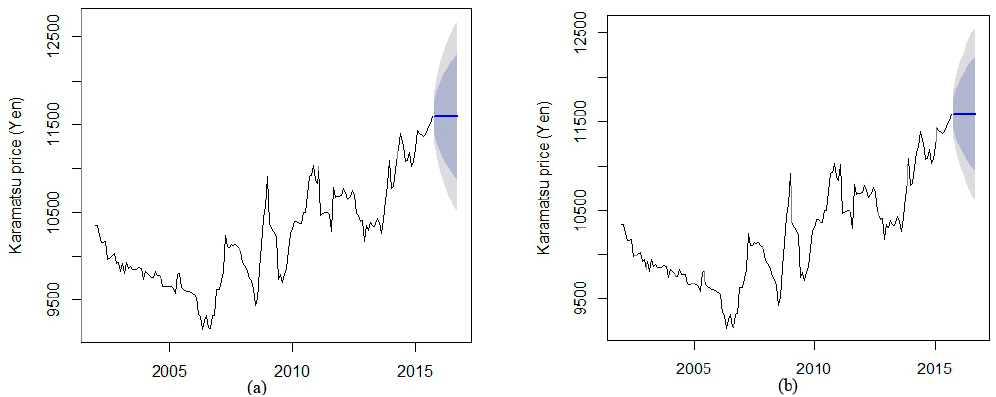
Figure 7. Forecasts of the karamatsu log prices: ( a ) Point forecasts and forecast intervals at 80% and 95% levels by ETS; ( b ) point forecasts and forecast intervals at 80% and 95% levels by ARIMA.